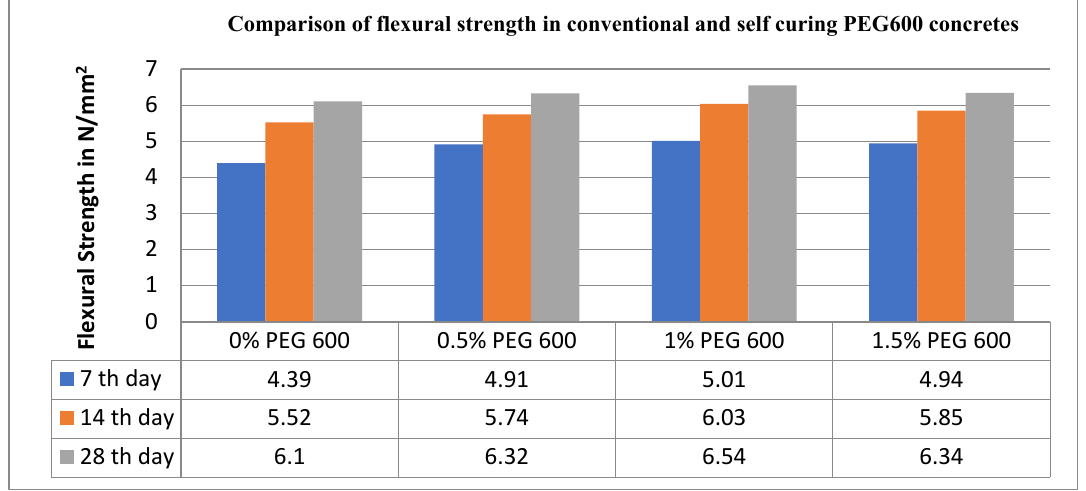
Self-curing polyethylene glycol (PEG-600) concrete with percentages of 0.0, 0.5, 1.0, and 1.5 were used, and test results are as shown in Figure 5. Comparison of flexural strength in conventional and self curing PEG600 concretes